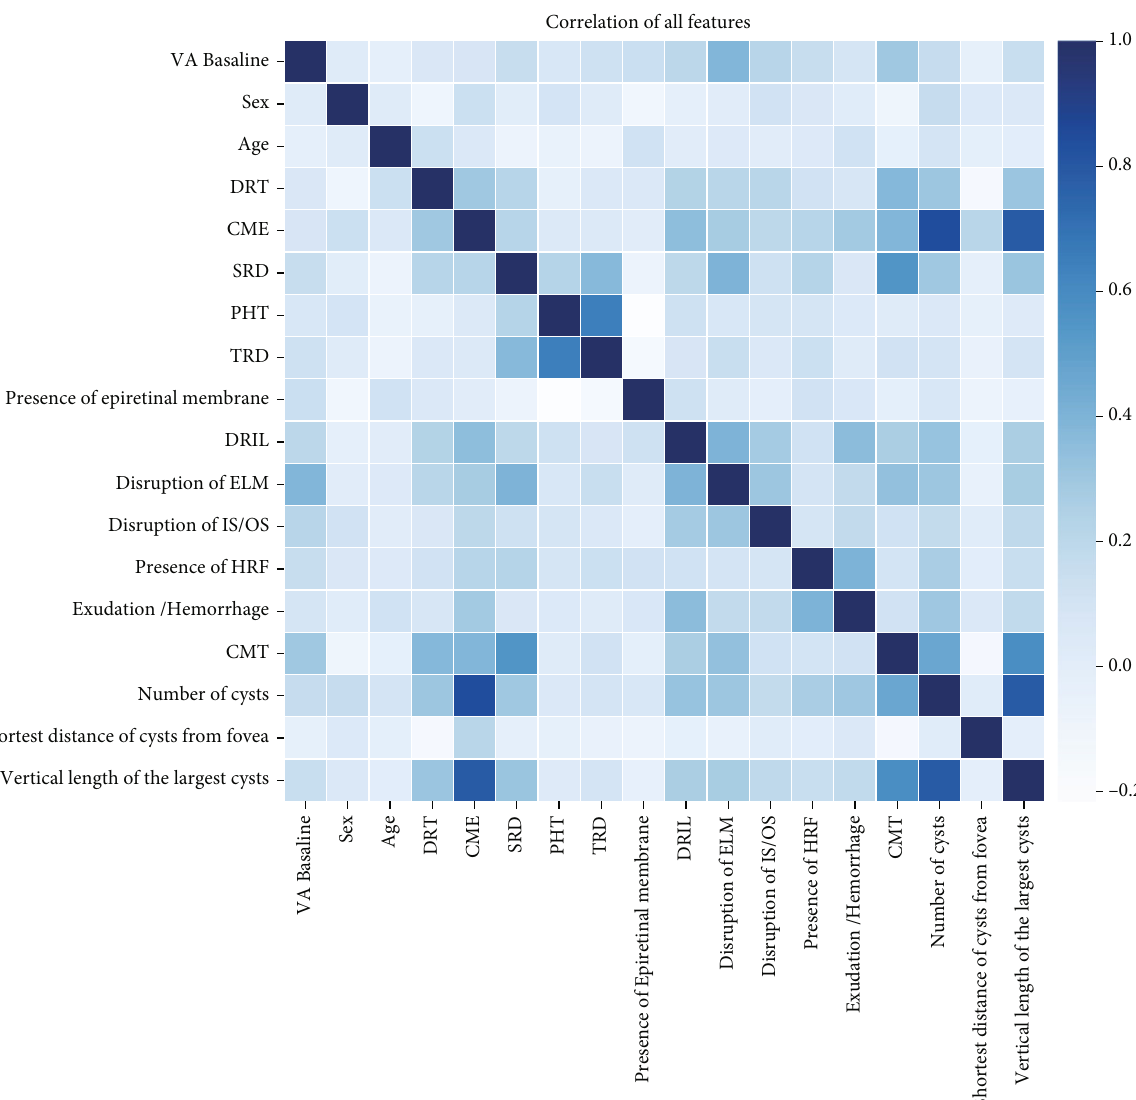
Figure 2: Correlation matrix of all baseline data. A correlation matrix was established for all baseline data to exclude redundant